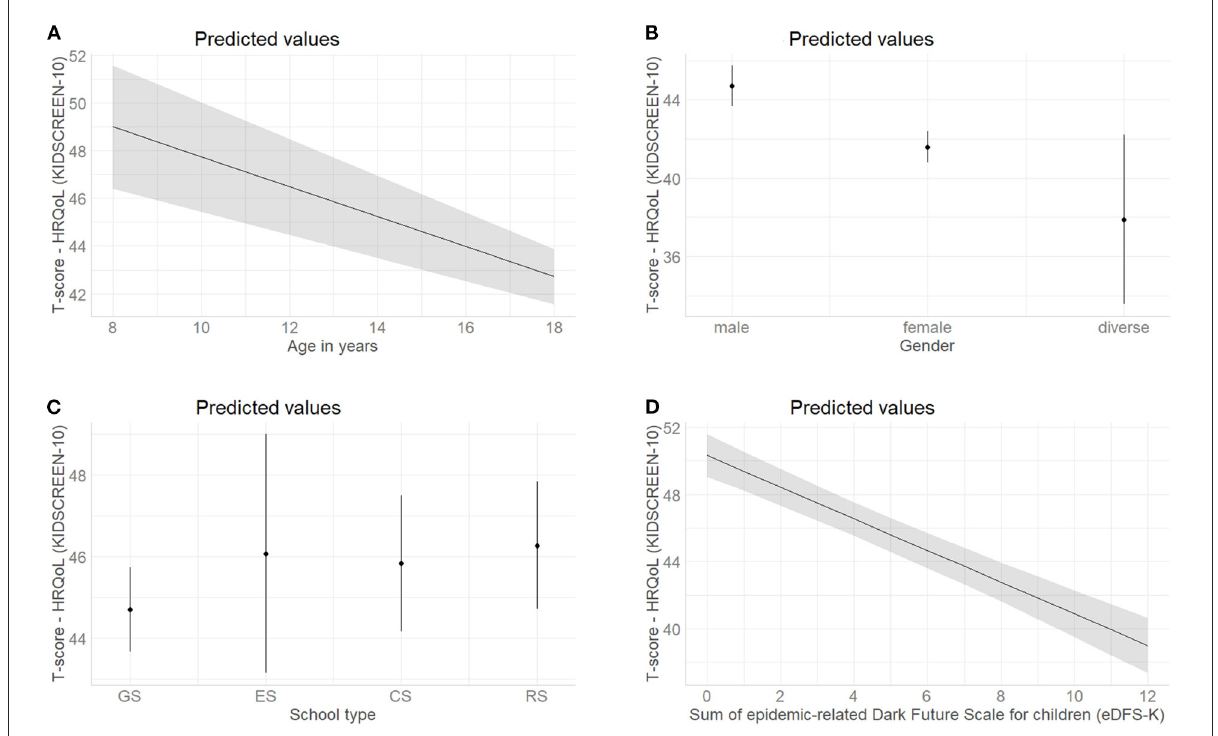
FIGURE1 Marginal effect plots with the predicted values and the 95% confidence interval of health-related quality of life (self-reported KIDSCREEN-10) for all predictors included in the multivariable model 1 (see Table 4, N = 787); (A) Estimated effect of age in years; (B) Estimated effect of gender; (C) Estimated effect of the school type, Abbr.: GS, grammar school; ES, elementary school; CS, comprehensive school; RS, regional school; (D) Estimated effect of sum of epidemic-related Dark Future Scale for children (eDFS-K). For continuous predictors, the gray lines and gray areas represent the estimated effect and 95% confidence interval, while for nominal variables this is represented by dots and dashes.